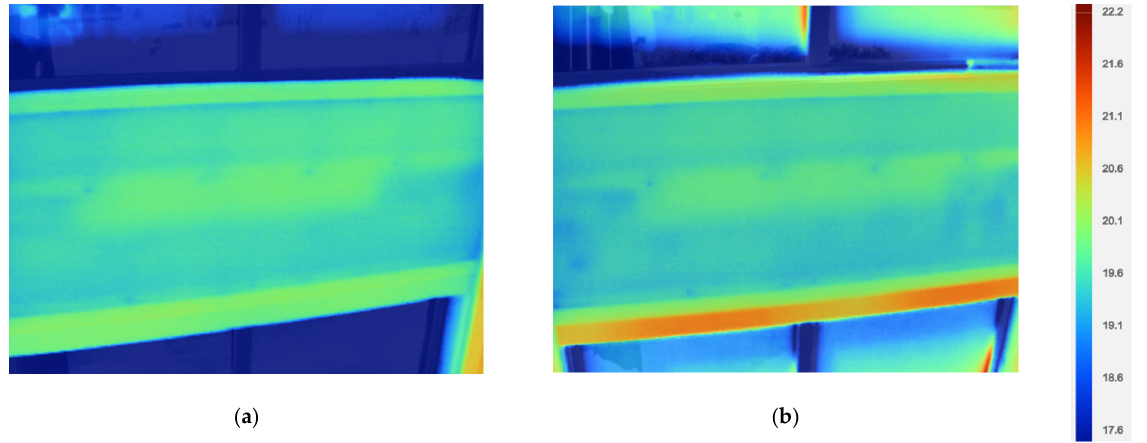
Figure 11. Thermographic analysis of House A and its new concept 2 sealing method at 0 Pa ( a ) and 50 Pa ( b )—photo taken inside house A in the staircase showing the junction between two exterior walls with windows (top and bottom of the photo).